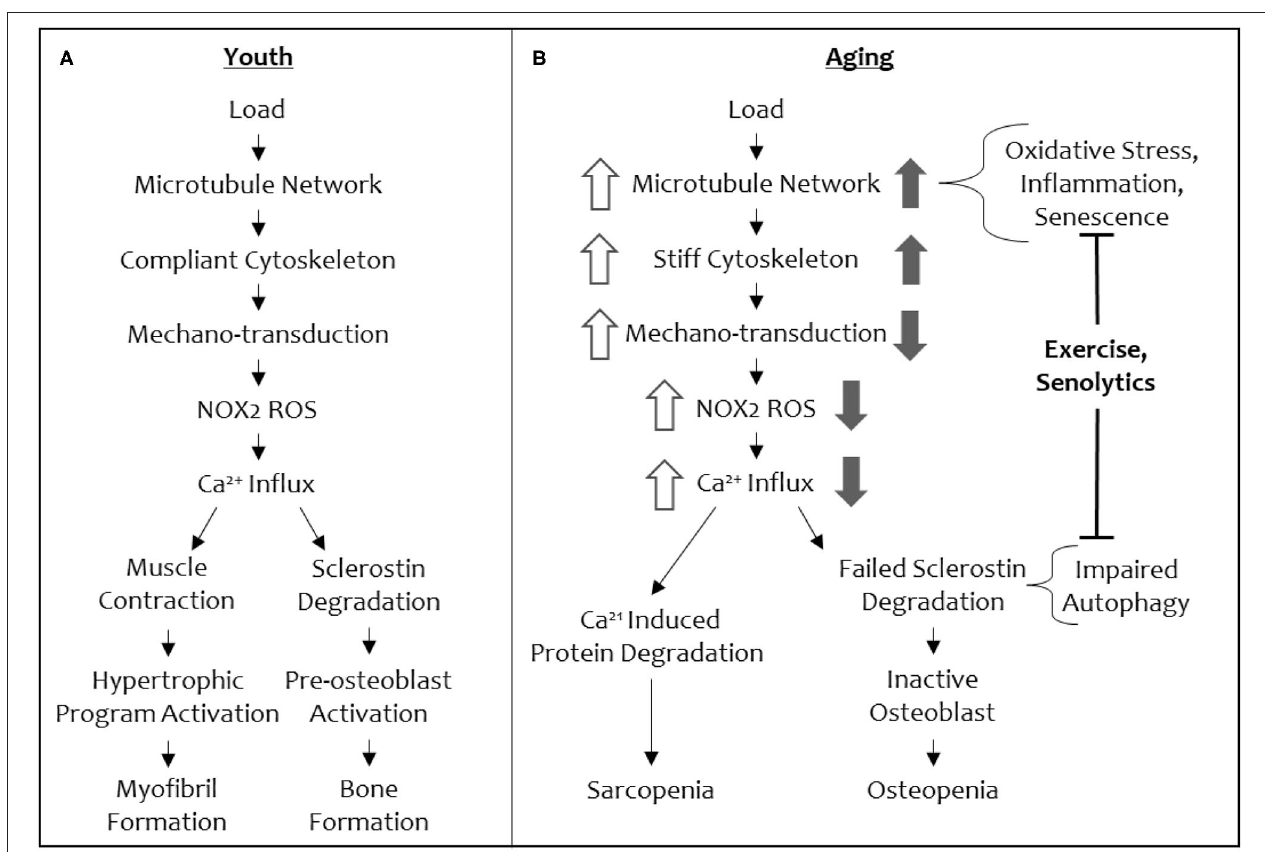
FIGURE 3 | A schematic of the shared mechano-transduction pathway in youth and in aging. Depiction of the shared mechanical load pathway in youth (A) and in aging (B) . Changes in signal magnitude by aging-related phenomena are indicated in open arrows (muscle) and solid arrows (bone).